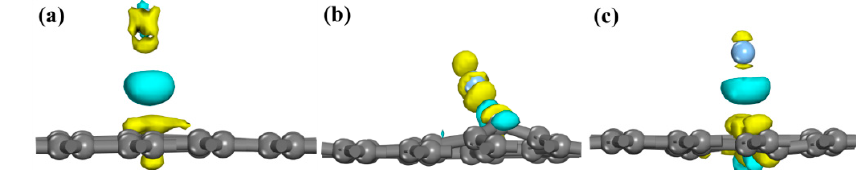
Figure 3. Electron density difference. The yellow and cyan regions represent charge depletion and charge accumulation, respectively. ( a ) Intrinsic graphene; Isosurface level: 0.015 eÅ − 3 ; ( b ) VG; Isosurface level: 0.05 eÅ − 3 ; ( c ) Ce-doped graphene. Isosurface level: 0.05 eÅ − 3.